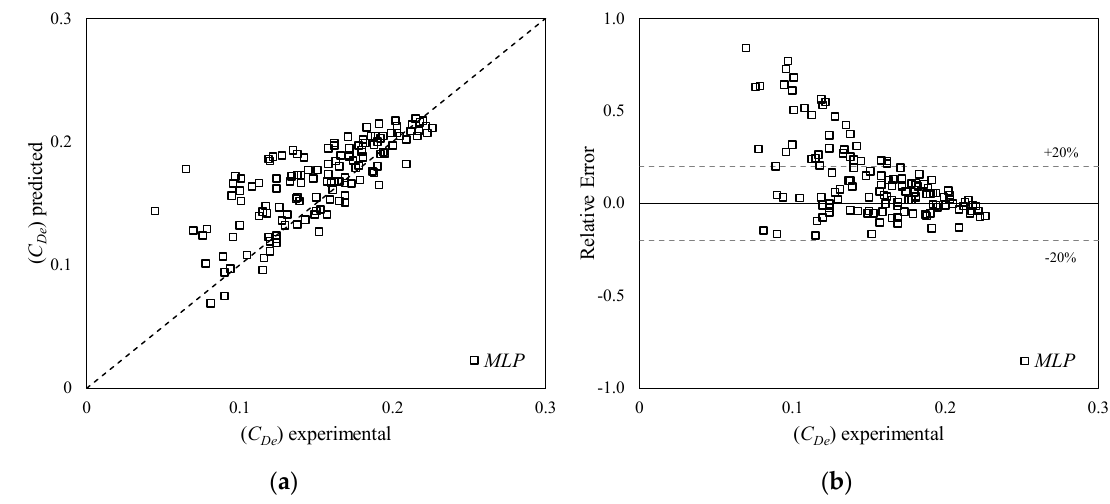
Figure 13. Model 2, MLP algorithm, ( a ) predicted versus experimental results, and ( b ) relative error versus experimental results.